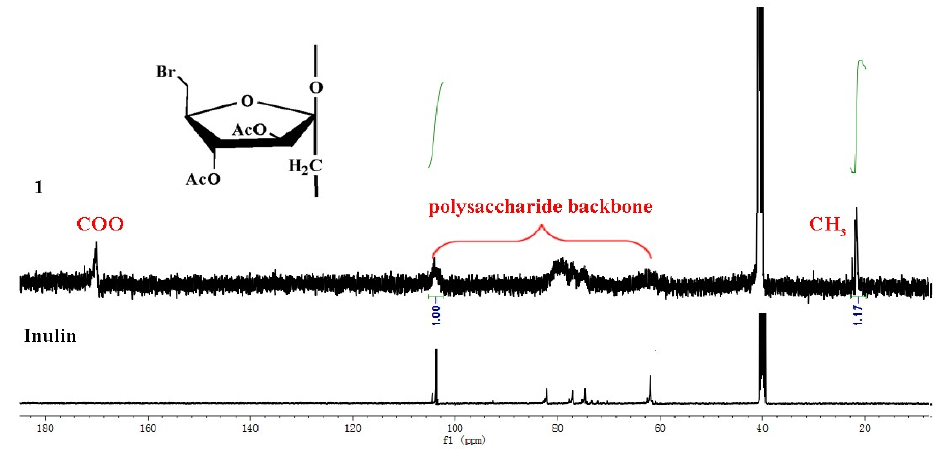
Figure 2. 13 C nuclear magnetic resonance ( 13 C NMR) spectra of inulin and 6-bromo-6-deoxy-3,4-acetyl inulin ( 1 ).